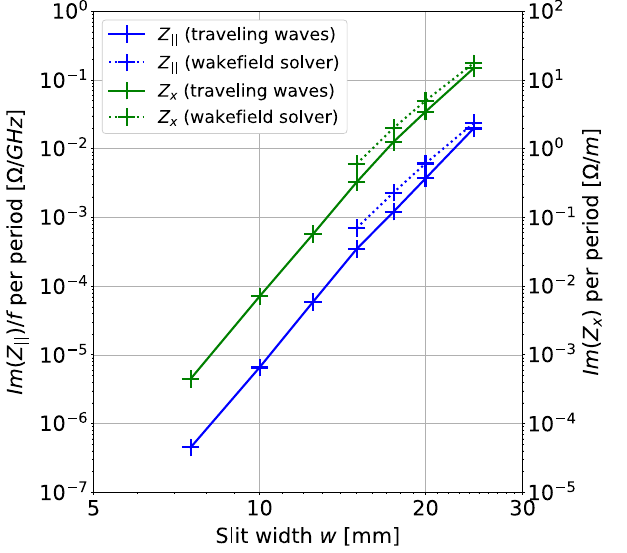
FIG. 9. Impedance of the holes in the FCC-hh beam screen as a function of the slit width.